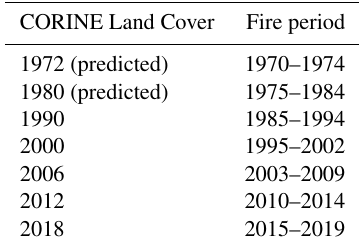
Table 2. CORINE Land Cover layers and their respective fire peri-